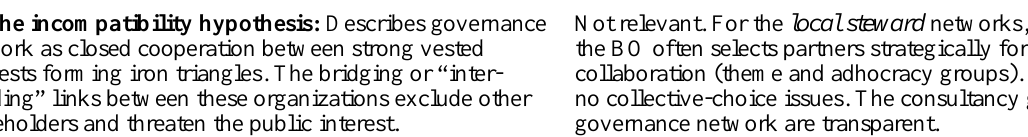
Table 2 . Four governance network hypotheses in relation to KVBR Governance network hypotheses (in relation to representative democracy)